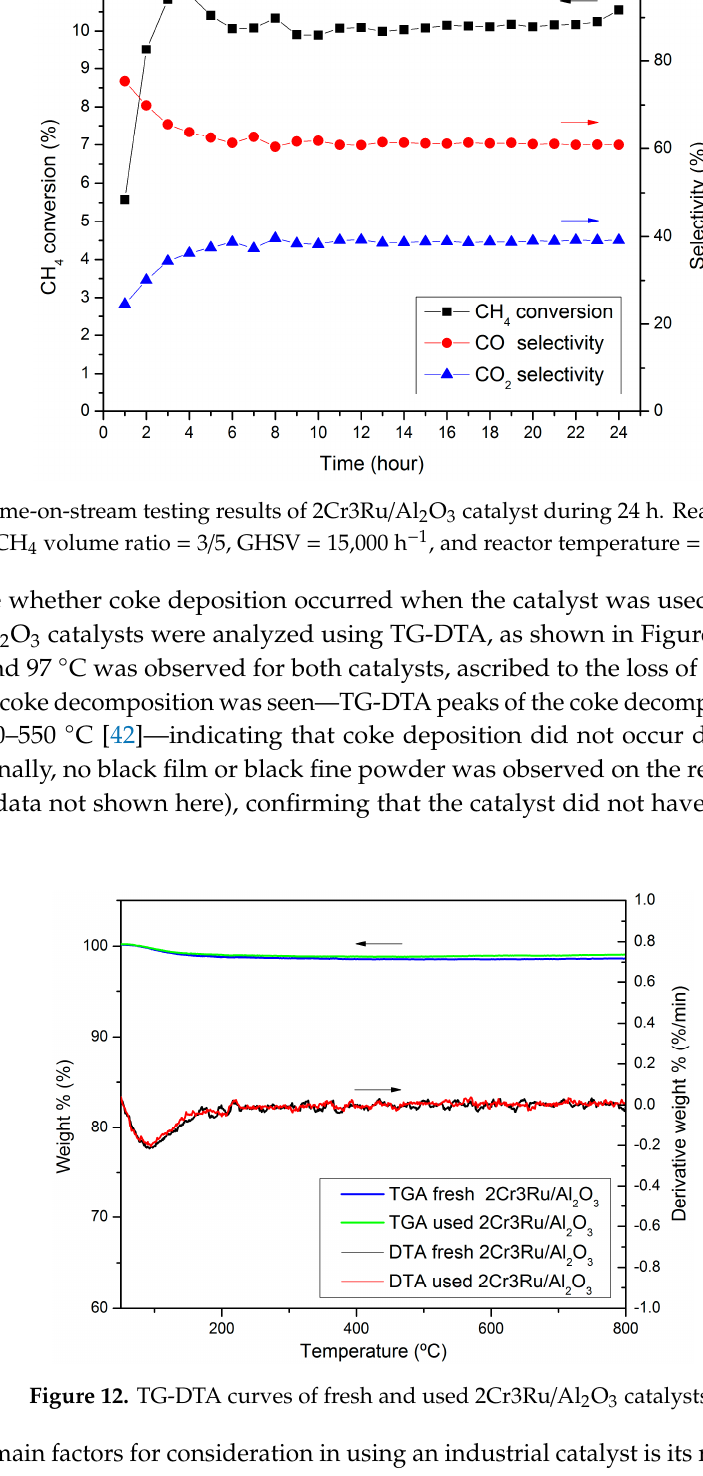
Figure 12. TG-DTA curves of fresh and used 2Cr3Ru/Al 2 O 3 catalysts.